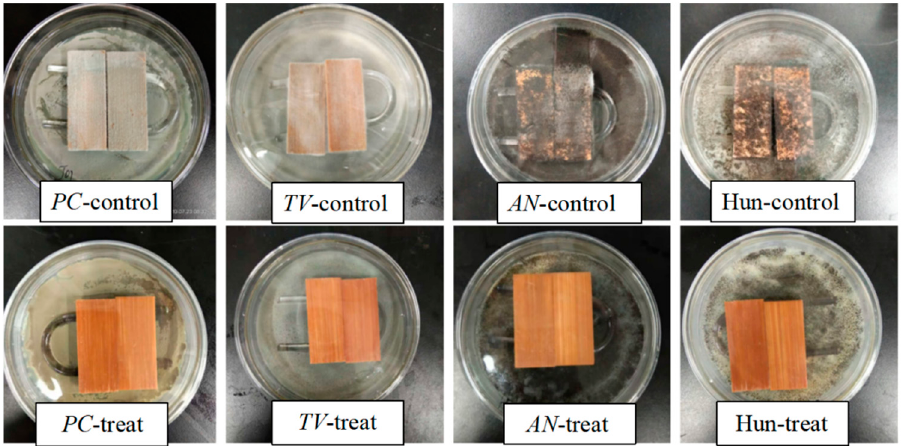
Figure 7. Antimildew photographs of untreated and treated bamboo strips on day 28.